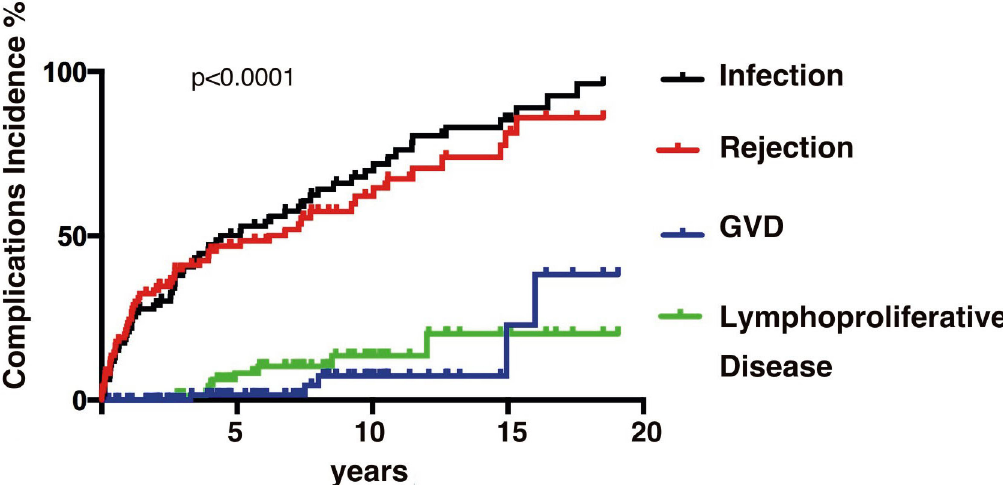
Fig. 4 - Graph illustrating incidence of complications during Heart Transplant follow-up. GVD= Graft Vascular Disease; n= number of patients at risk P>0.05 when comparing infection versus rejection; P<0.0001 when compared Infection versus GVD; P<0.0001 when comparing infection versus Lymphoproliferative Disease; P<0.0001 when comparing rejection versus GVD; P<0.0001 when comparing rejection versus Lymphoproliferative Disease; P>0.05 when comparing GVD